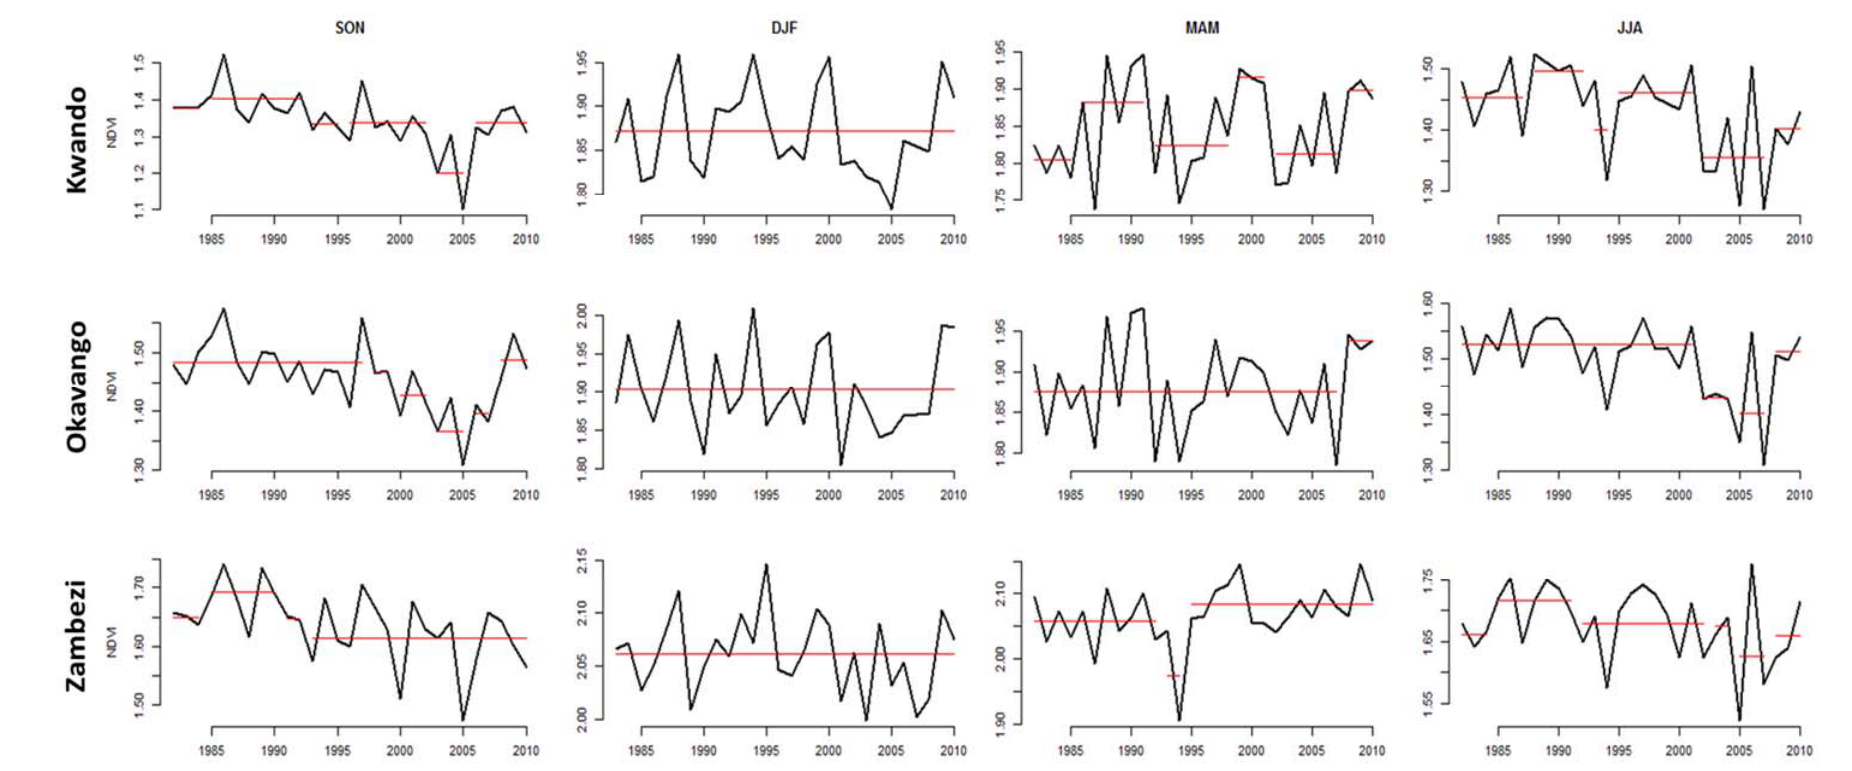
Figure 8. NDVI change point statistical analysis with each row representing one catchment and each column a season from 1982–2010. Red lines indicate the regimes highlighted during the change point analysis.